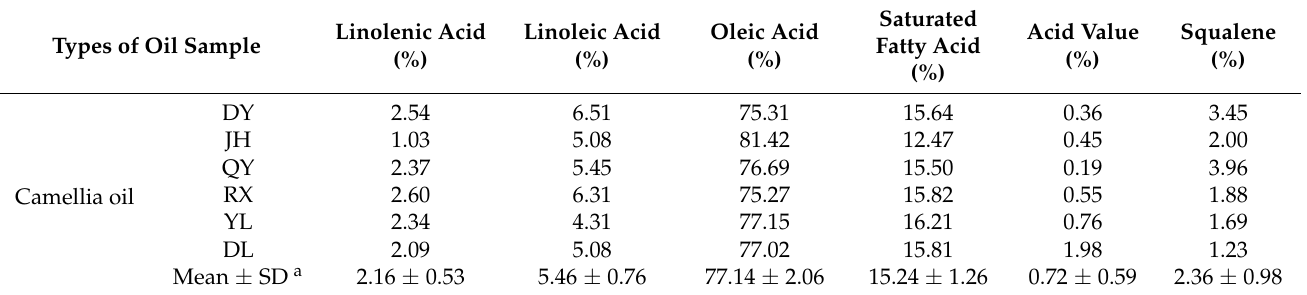
Table 1. Relative contents of main components and evaluation indexes in camellia oil and olive oil, as determined by high field NMR. Types of Oil Sample